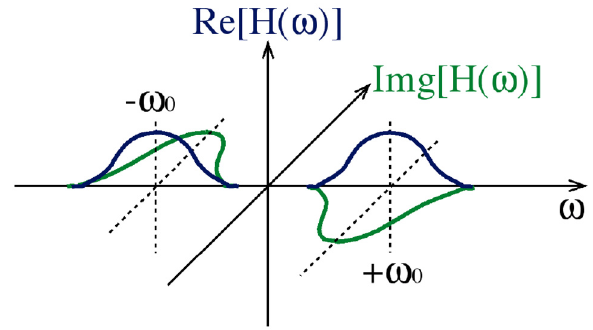
Figure 7. Fourier transform of a Morlet wavelet.